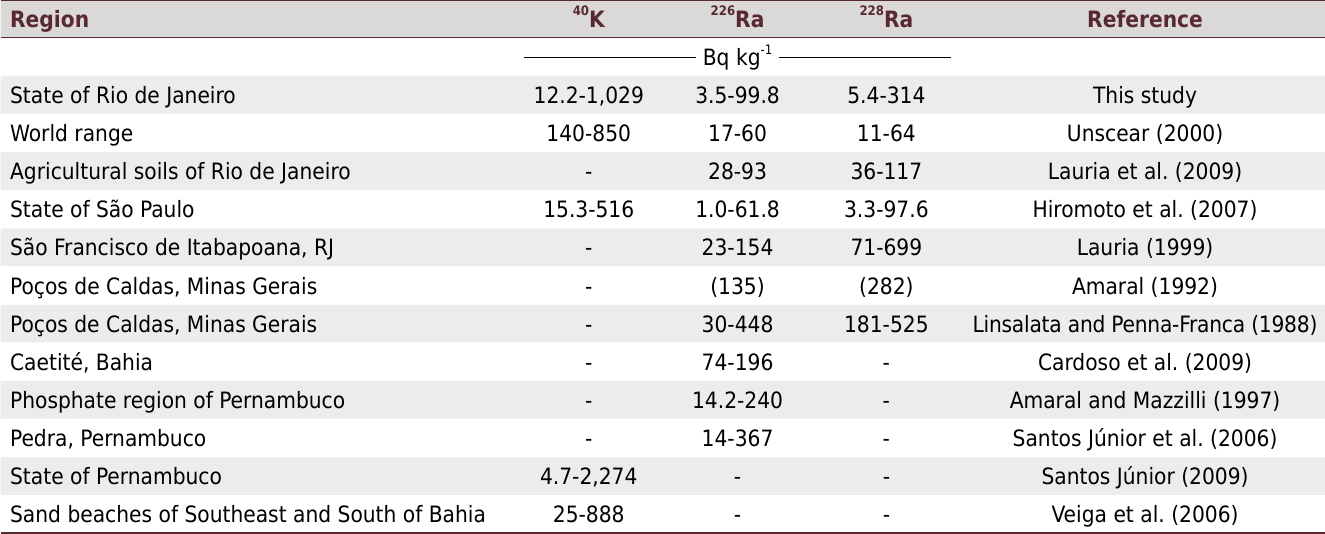
Table 4. Activity content of 40 K, 226 Ra, and 228 Ra reported in other studies for Brazilian soils